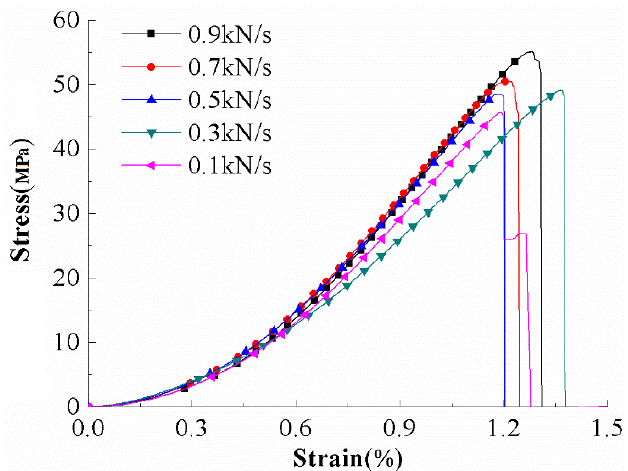
Figure 4. Stress-strain curves of yellow sandstone under different loading Figure 4. Stress ‐ strain curves of yellow sandstone under different loading rates. Yellow sandstone’s peak strength under different loading rates is shown in Figure 5.